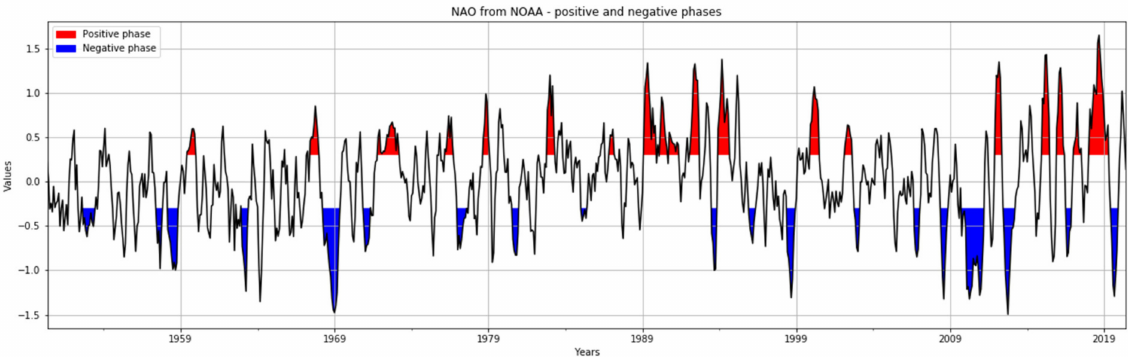
Figure 13. Time series of episodes of strong positive and strong negative phases of the NAO. Figures 14 and 15 depict the tendency of the quasi-periodicity of both positive and negative phases of the NAO (see Figure 13 and Tables S3 and S4) to decrease.